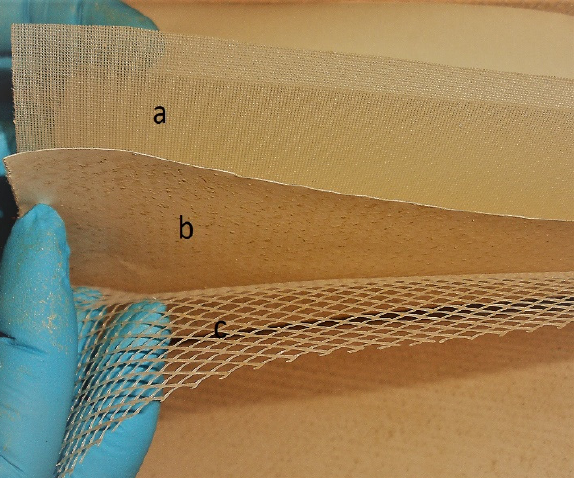
Figure 2. Internal parts of the discarded RO module reused as supports for the nanofibrous MD membranes: (a) permeate spacer, (b) RO membrane and (c) feed spacer.